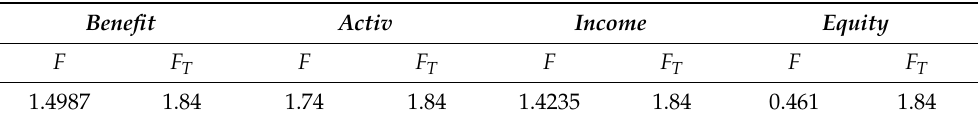
Table 4. Values of the Fisher criterion for estimating statistical proximity of variances D ( X )